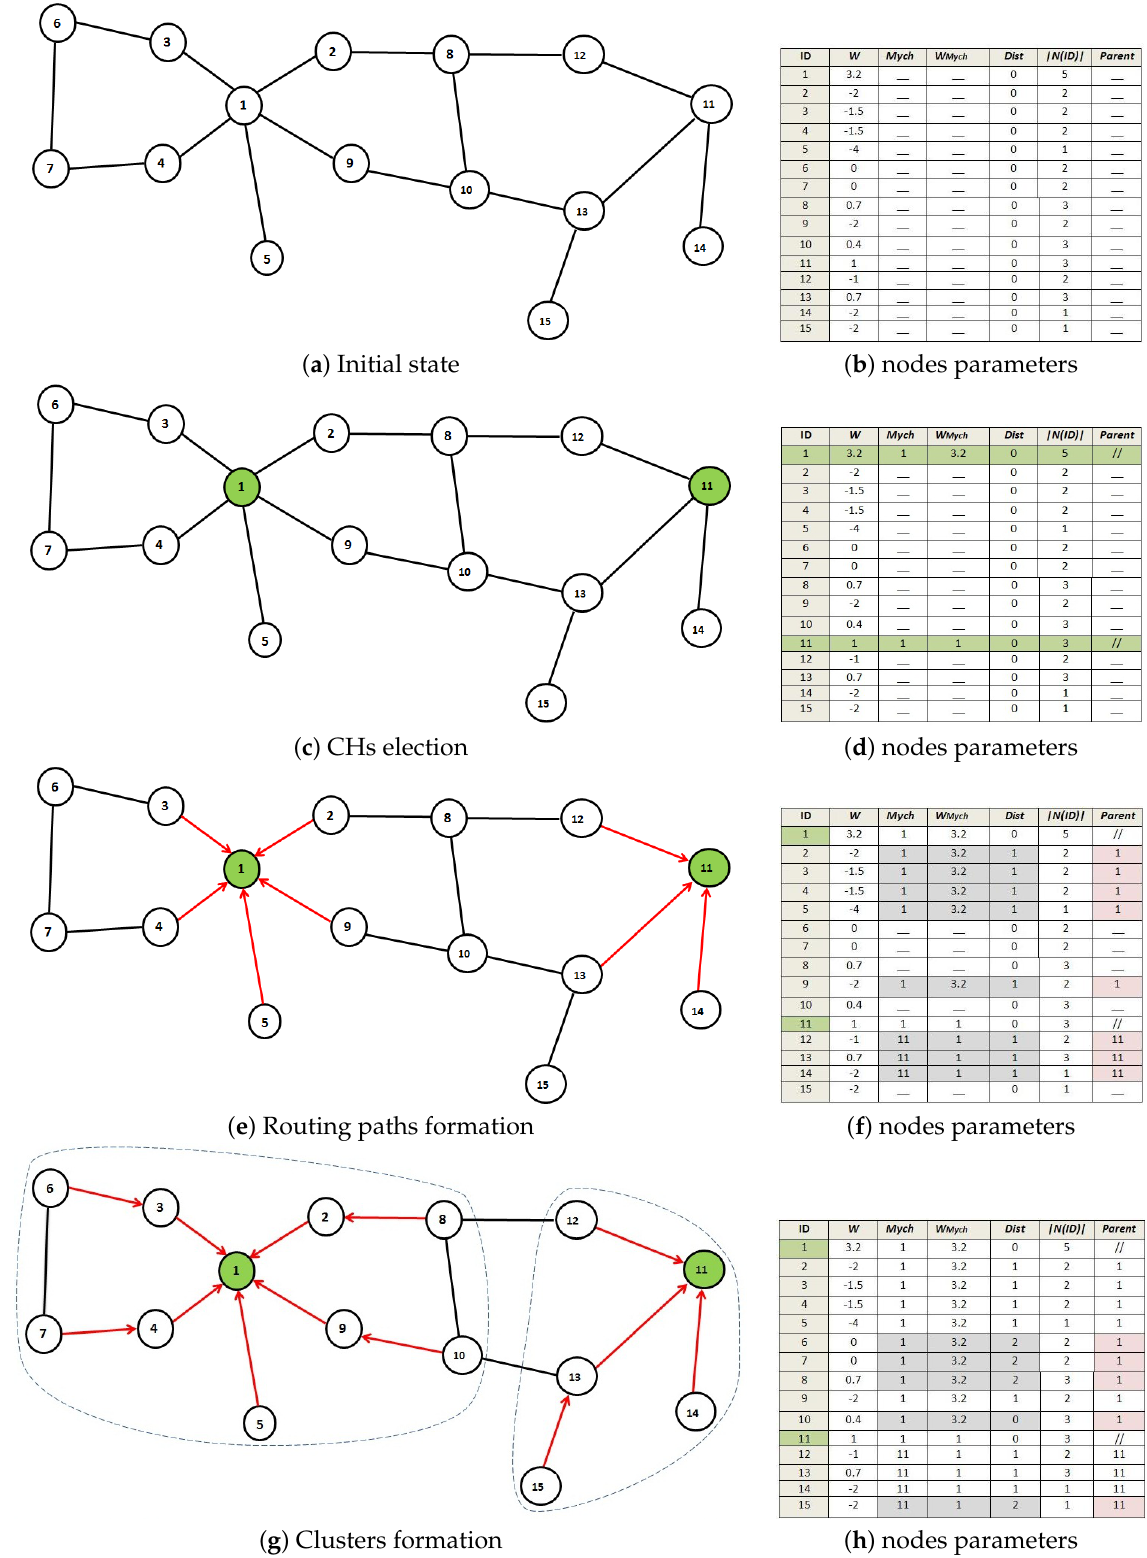
Figure 6. Execution scenario of Distributed Clustering based 2-Hop Connectivity (DC2HC) clustering